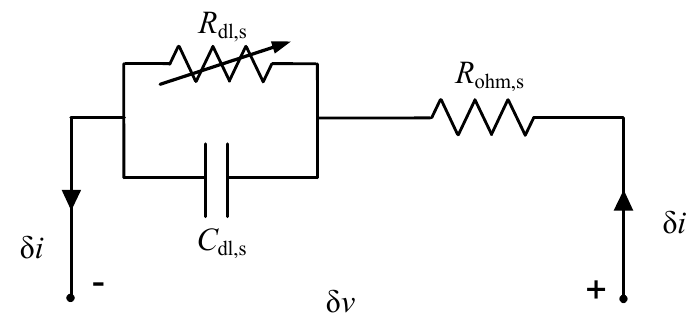
Figure 6. Small signal model of the electrical performance of the Fuel